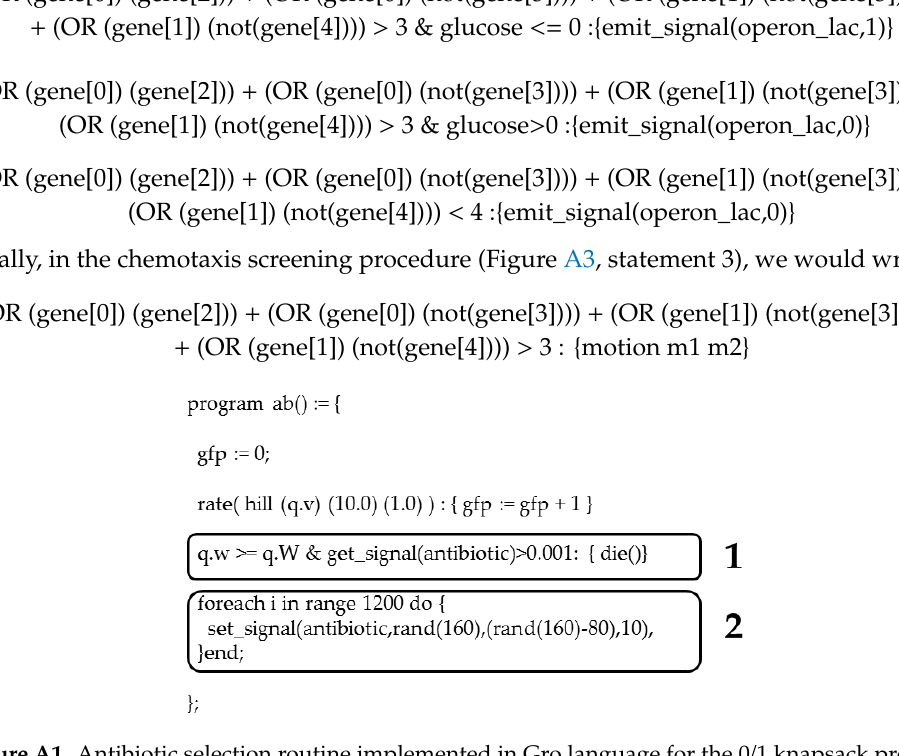
Figure A1. Antibiotic selection routine implemented in Gro language for the 0 / 1 knapsack problem. The code shows q.w or weight of the knapsack and q.W, which is the maximum capacity (weight) of the knapsack. ( 1 ) Conditional sentence of the antibiotic resistance. ( 2 ) Antibiotic signal randomly distributed in the environment where the colony of synthetic bacteria grows.